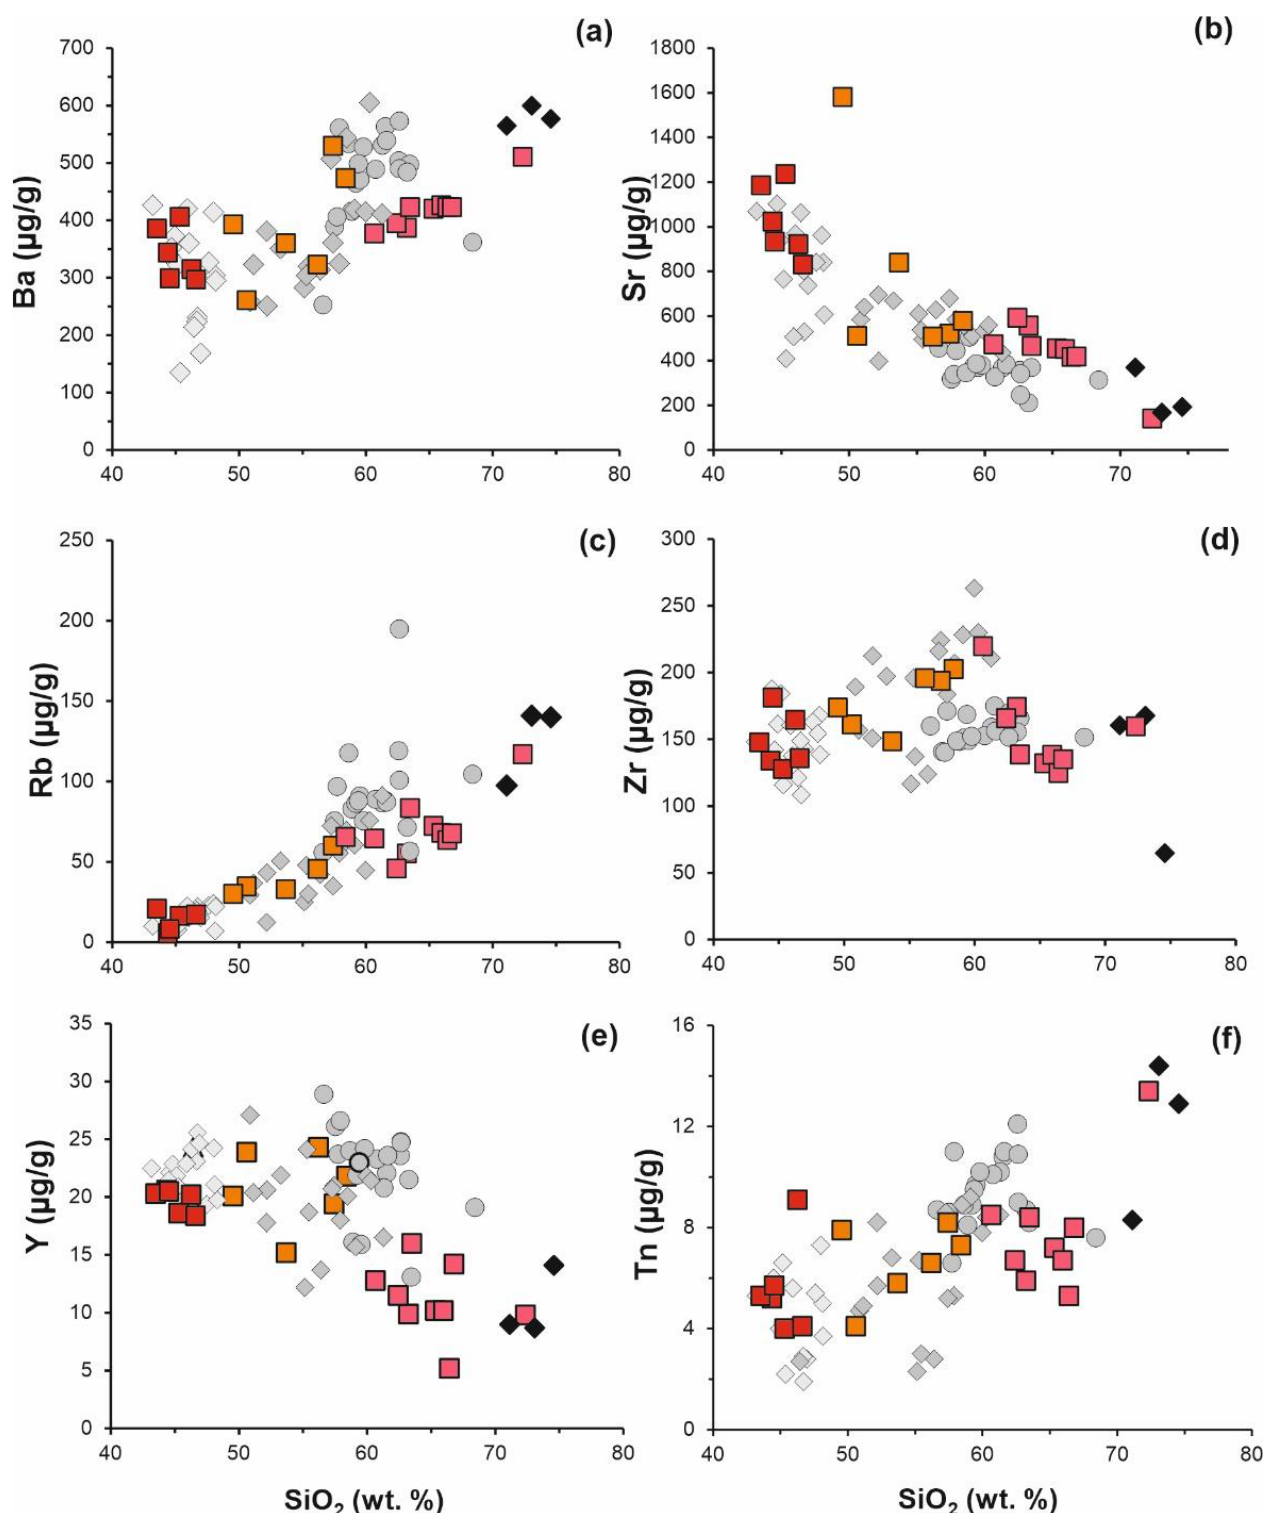
Figure 9. ( a – f ) Harker minor element diagrams of SNV (the symbols as Figure 7).